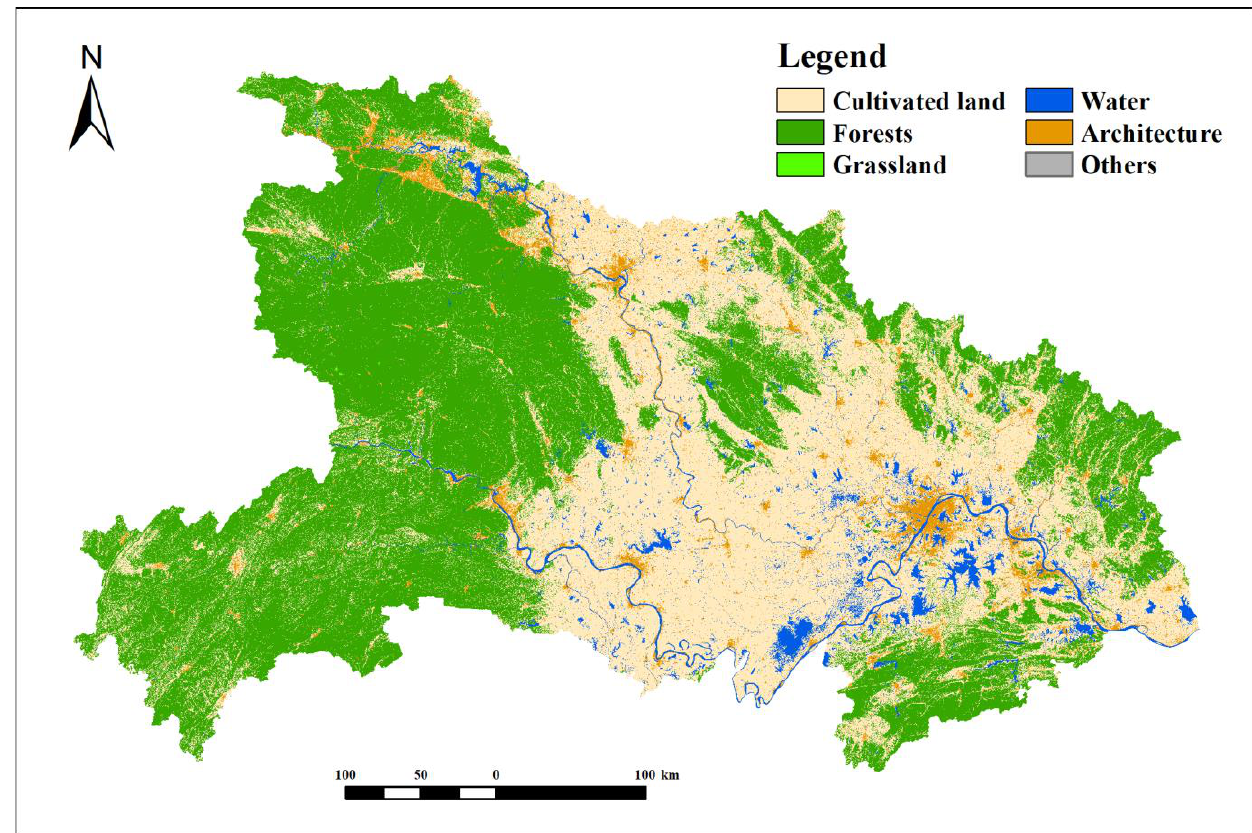
Figure 10. Simulation results for land use in 2035 in the economic priority scenario.